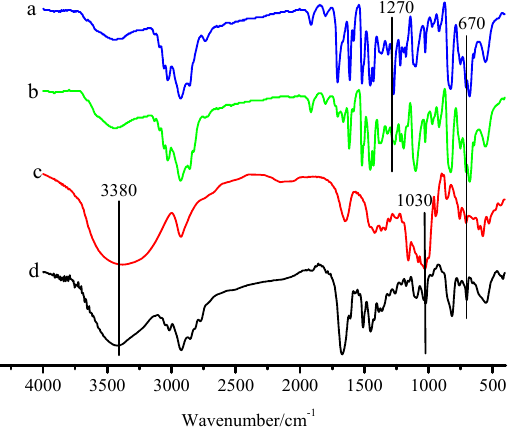
Figure 3. FTIR of crosslinked chloromethylated polystyrene (CM-PS) ( a ), HCP ( b ), β -CD ( c ), and CDM-HCP ( d ).